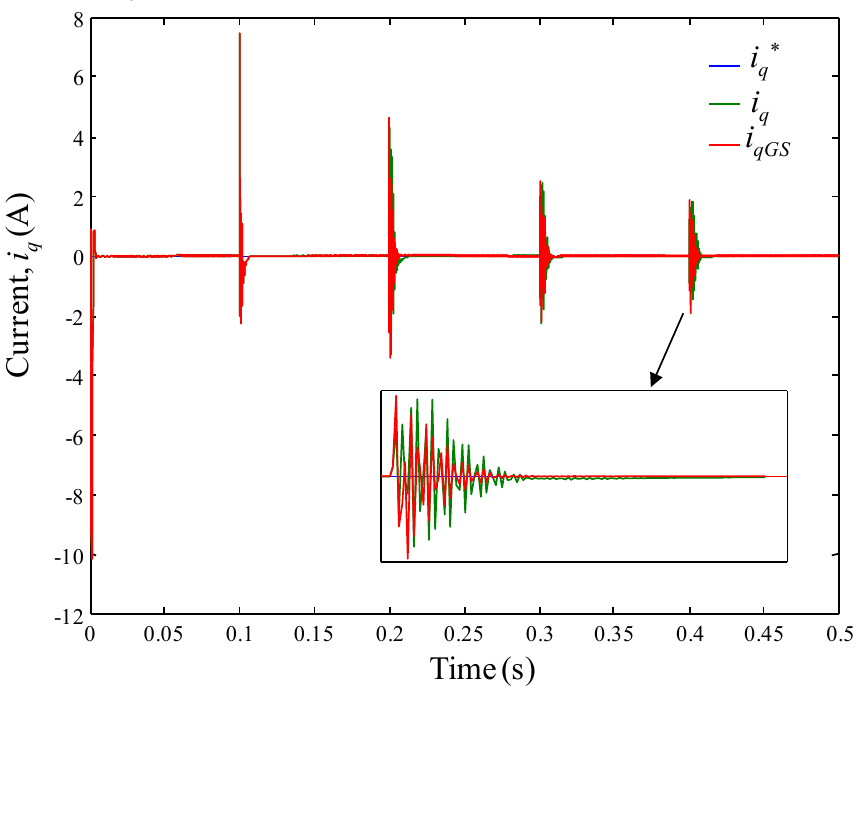
in regulation, for the two controllers, when R changes q , 2 R , 4 R , 6 R , 8 R nom nom nom nom nom